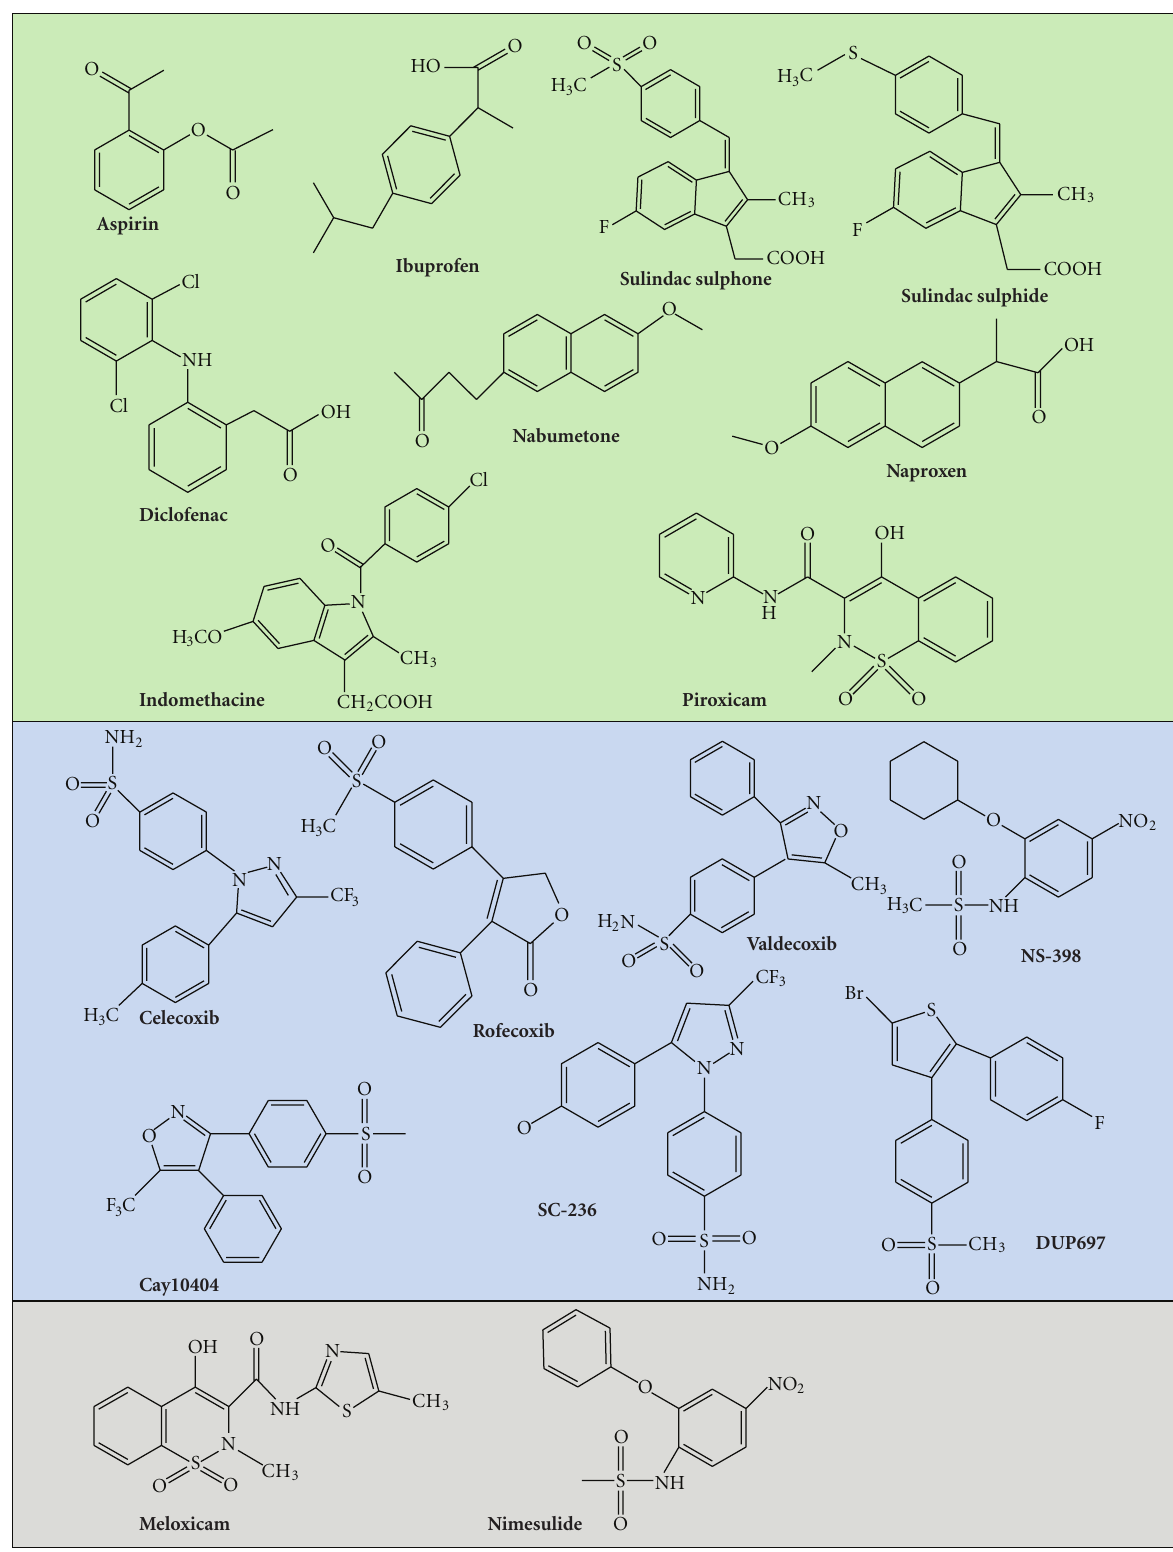
Figure 2: COX-2 inhibitor classification. COX-2 is the target of many compounds. COX-2 inhibitors described in this review are classified according to their ability to inhibit COX-2: nonselective (green), selective (pale blue), and preferential